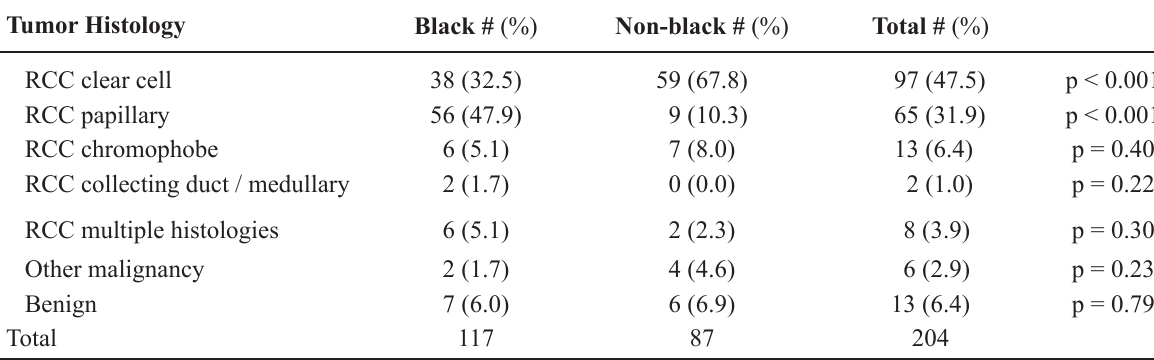
Table 2 – Race and tumor